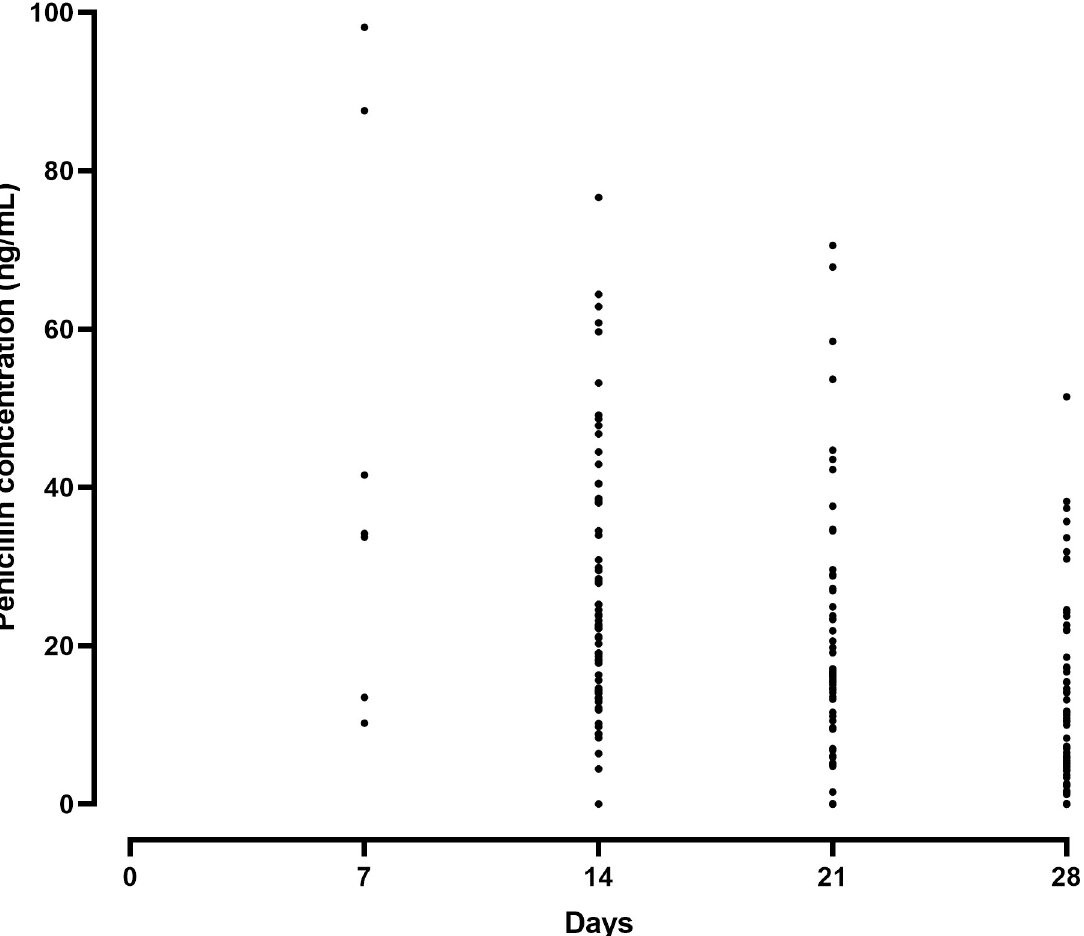
Fig 1. Measured penicillin concentrations following benzathine penicillin G injection in Ethiopian patients with rheumatic heart disease.